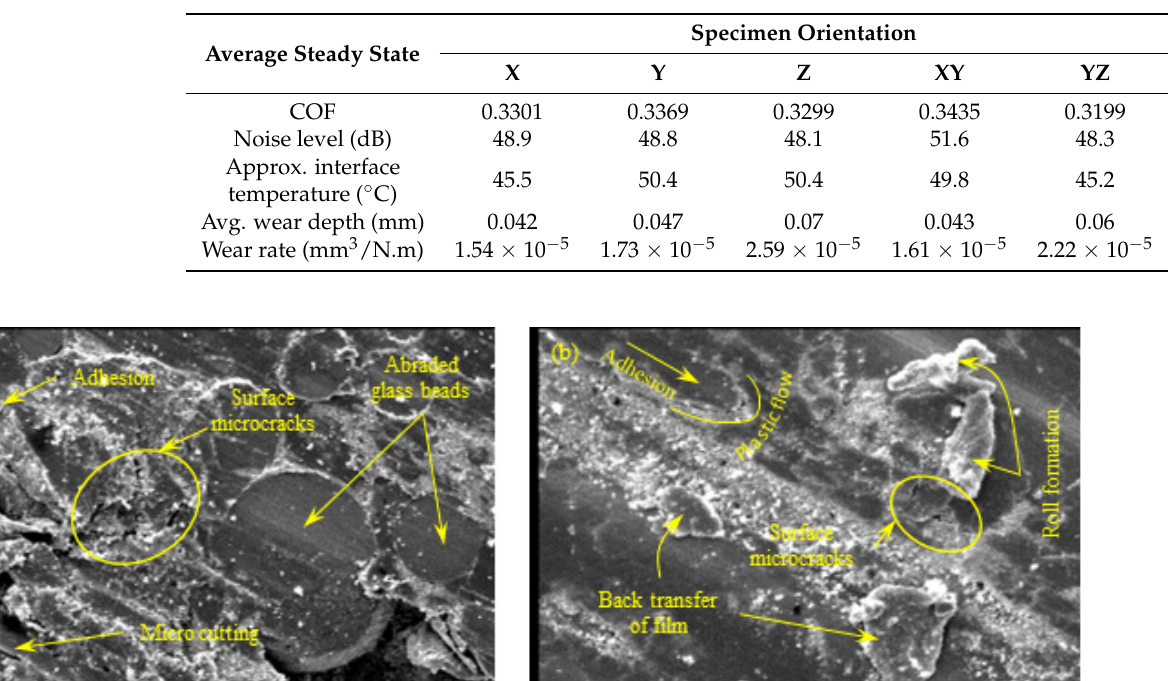
Table 3. Average values of steady-state performance parameters.